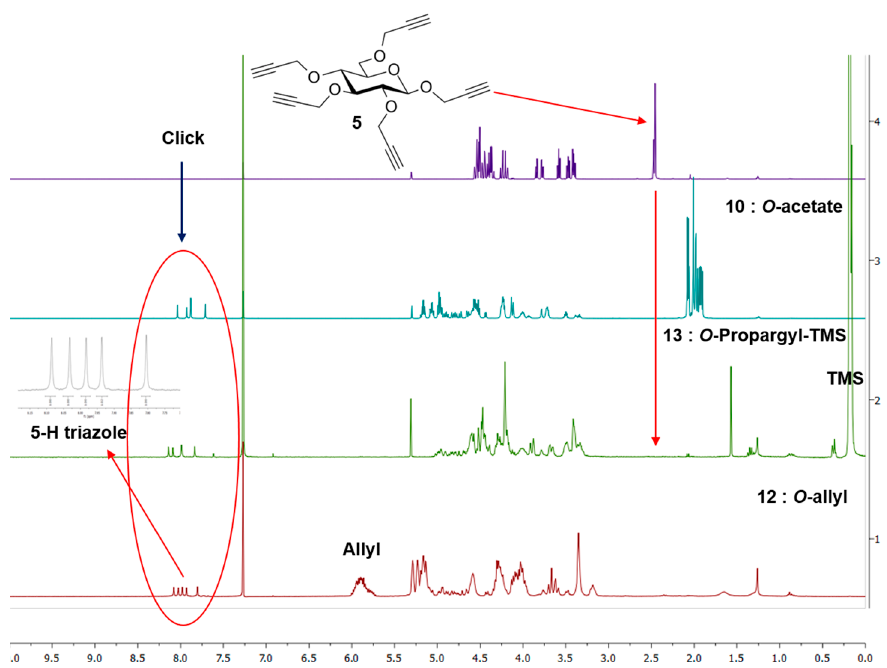
Figure 1. NMR spectra of key precursor 5 and G 1 dendrimers 10 , 12 and 13 . Insert: Expanded triazole signals of 12 .